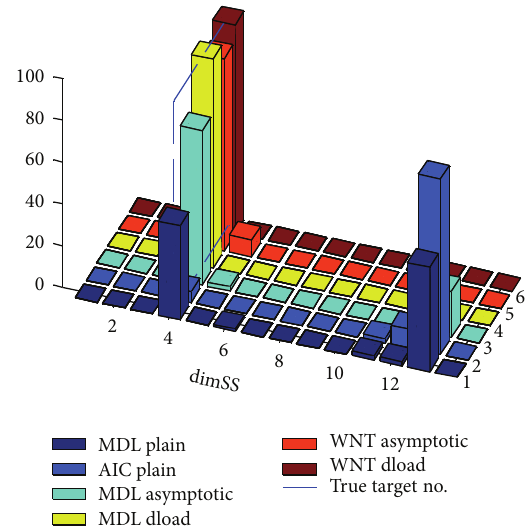
Figure8:Comparisonoftestsforlineararraywith 𝑁 = 14 elements, 𝐾 = 14 snapshots, with and without asymptotic correction or diagonal loading (dload) of 1𝜎 2